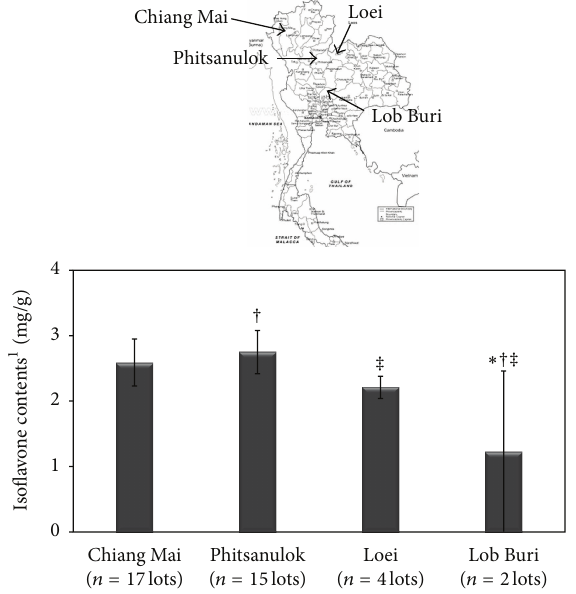
Figure 6: Isoflavone content in sound seeds of Chiangmai 60 soybean variety grown in dry season crop year 2010 and obtained from 4 agricultural research centers in Thailand. The soybean samples from each site were from different lots. Each lot was extracted and assayed in triplicate. ∗ 𝑃 < 0.05 compared to Chiang Mai province. † 𝑃 < 0.05 compared to Loei province. ‡ 𝑃 < 0.05 compared to Phitsanulok province. Bars and error bars represent mean ± standard deviation. 1 Isoflavone content was the summation of daidzin and genistin contents.